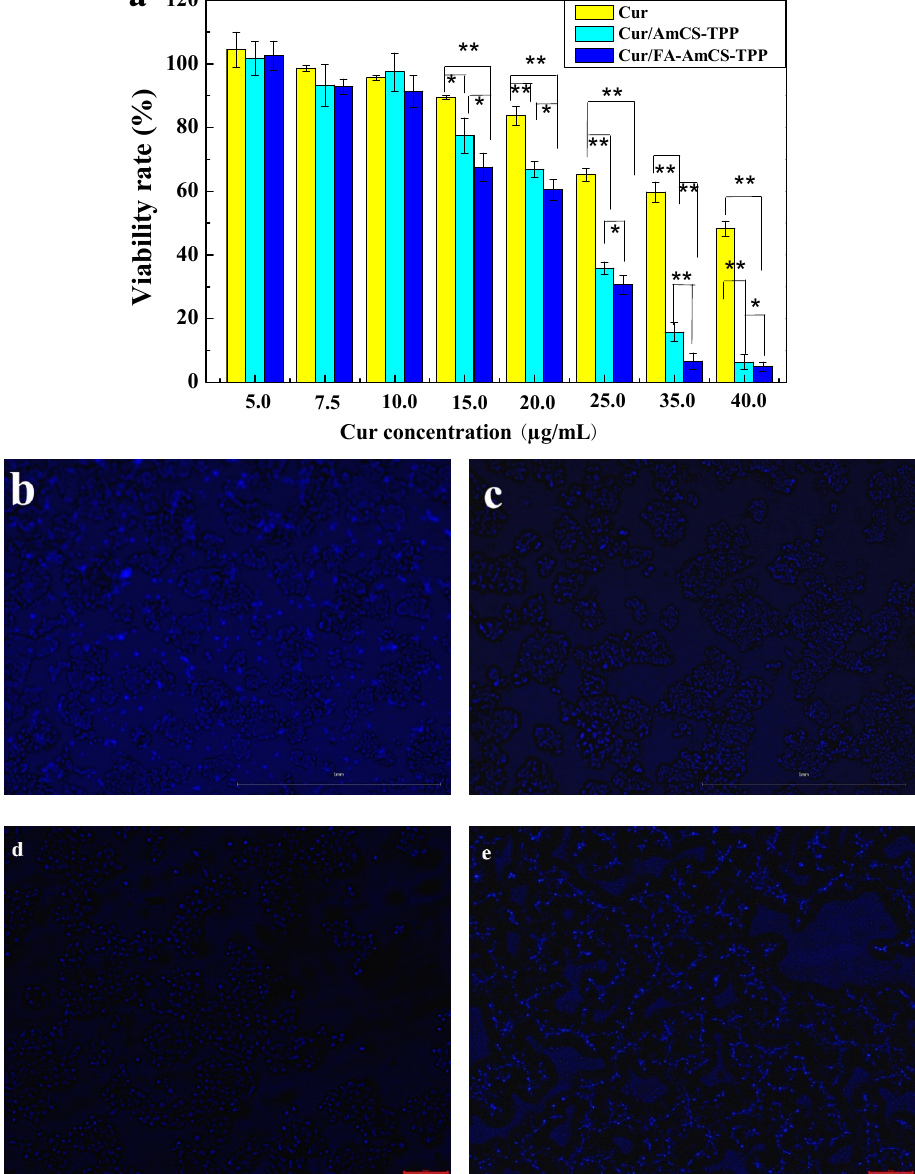
Figure 8. ( a ) Viability rate of LS174T colon cancer cell after treating with Cur ( ■ ), Cur/AmCS-TPP ( ■ ) and Cur/FA-AmCS-TPP ( ■ ) for 24 h (** p < 0.01, * p < 0.05, no labeling was not significant); fluorescence microscopic images of LS174T for coumarin-6 loaded AmCS-TPP for 0.5 h ( b ) and 1 h ( d ); fluorescence microscopic images of coumarin-6 loaded FA-AmCS-TPP for 0.5 h ( c ) and 1 h ( e ).